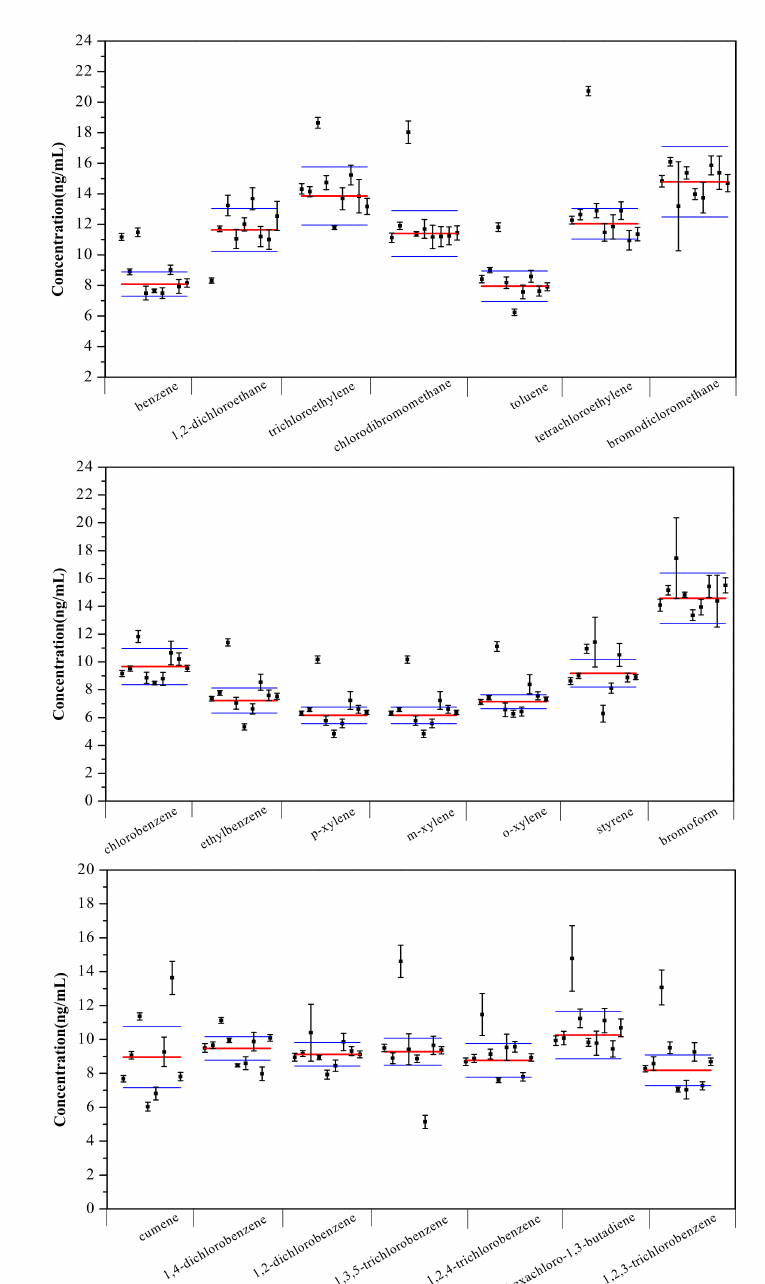
Figure 4. Measurement of 28 VOCs in water from nine laboratories. Thick red lines represent certified values, thin blue lines represent expended